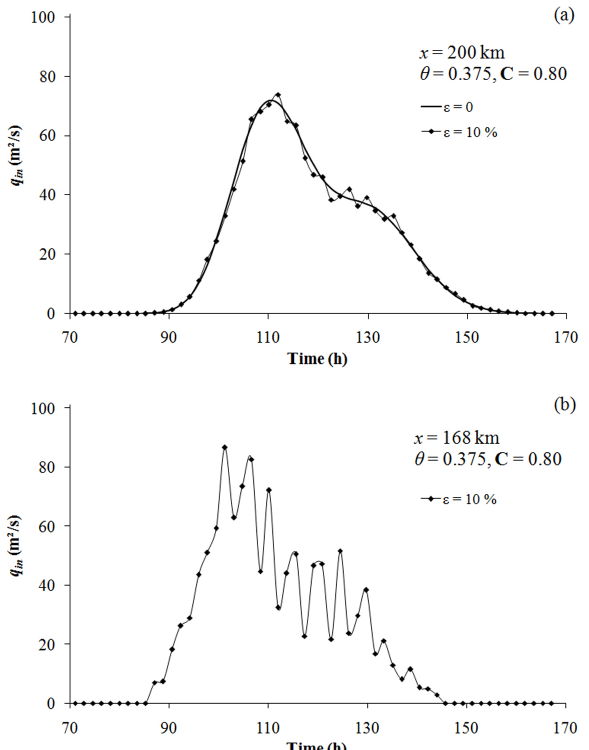
Fig. 6. (a) Field measurements of outflow hydrograph, “perfect”, (cid:15) = 0%, and seeded with error (cid:15) = 10%; (b) reverse-computed dis- charge hydrograph after a few space steps.